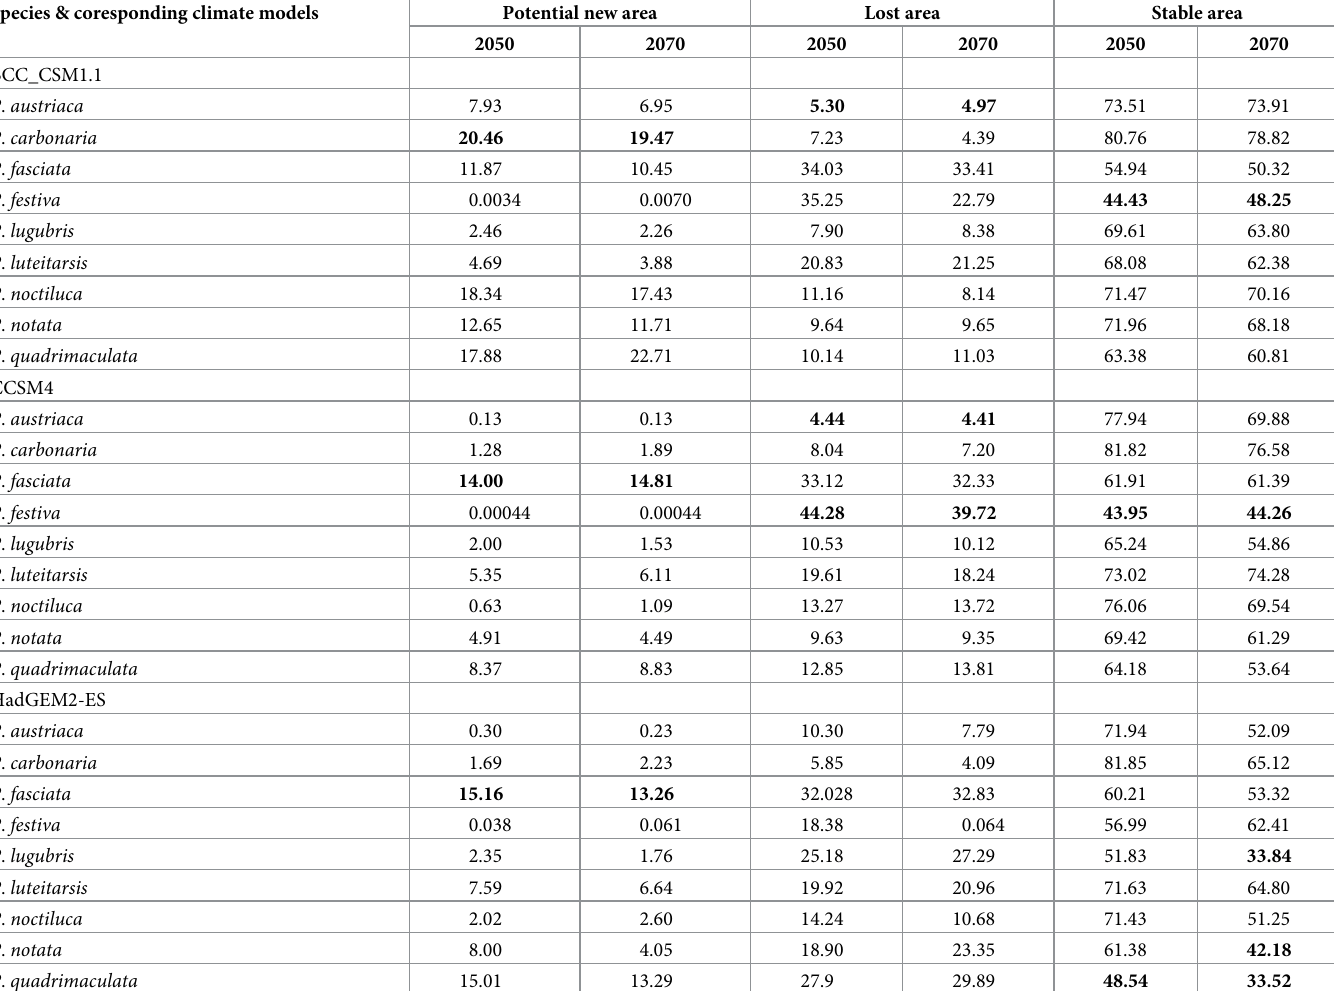
Table 2. Percentages of potential new, lost and stable areas for each Pipiza species in Europe based on the BCC_CSM1.1, CCSM4 and HadGEM2-ES climate model predictions and all scenarios. Bold numbers indicate the smallest and highest percentage. Species & coresponding climate